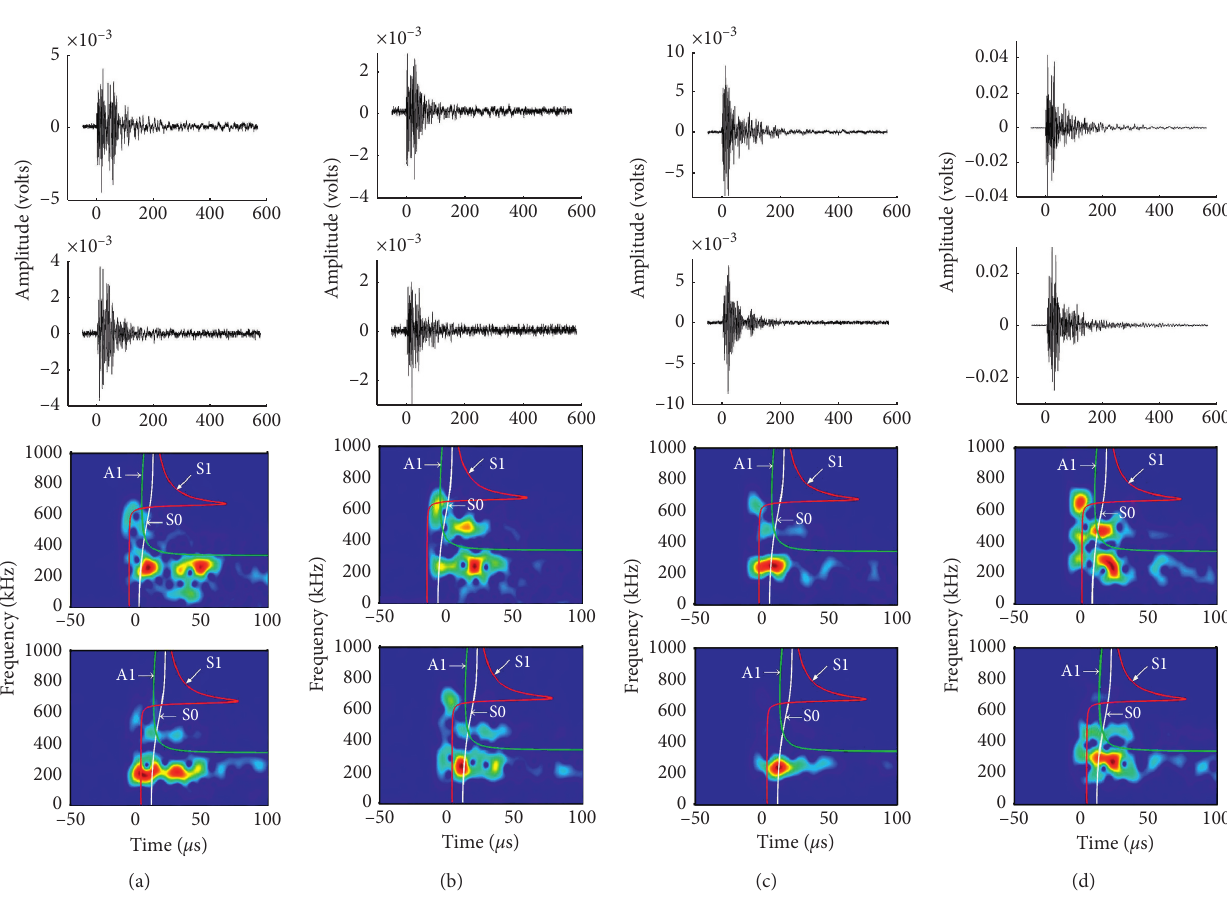
� 52.2 s. (b) t � 101.9s. (c) t � 145.3 s. (d) t � 4 ] s layup. (a) t